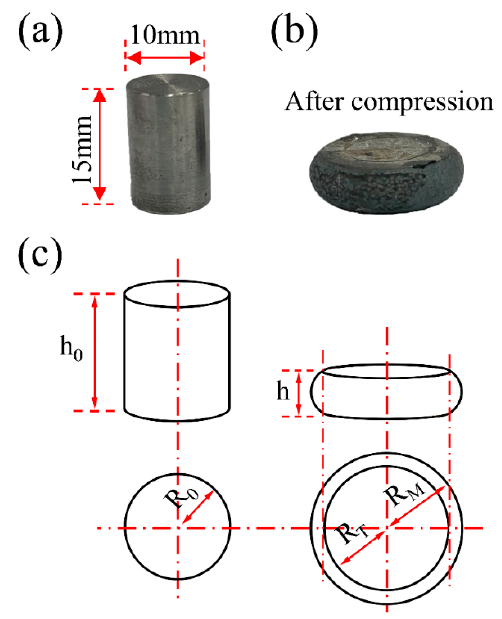
Figure A1. Diagram of samples shape before ( a ) and after ( b ) hot compression, and ( c ) relevant parameters in friction correction.